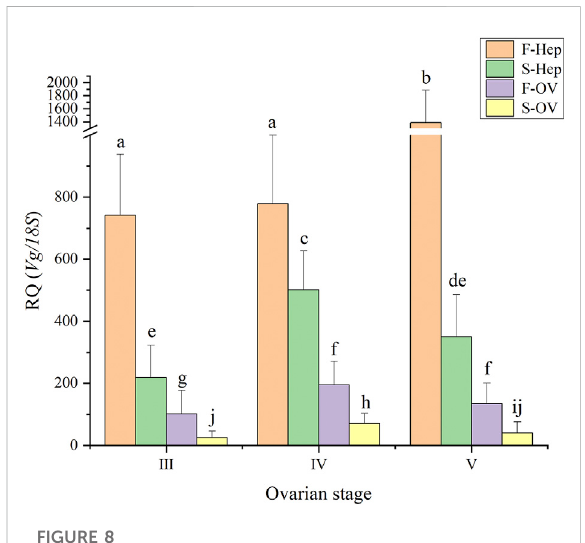
FIGURE 8 The Sp-Vg expressionlevels intheovaryand hepatopancreas of Scylla paramamosain during the two vitellogenesis periods. F-Hep, the hepatopancreas of the FVP; S-Hep, the hepatopancreas of the SVP; F-OV, the ovary of the FVP; S-OV, the ovary of the SVP.